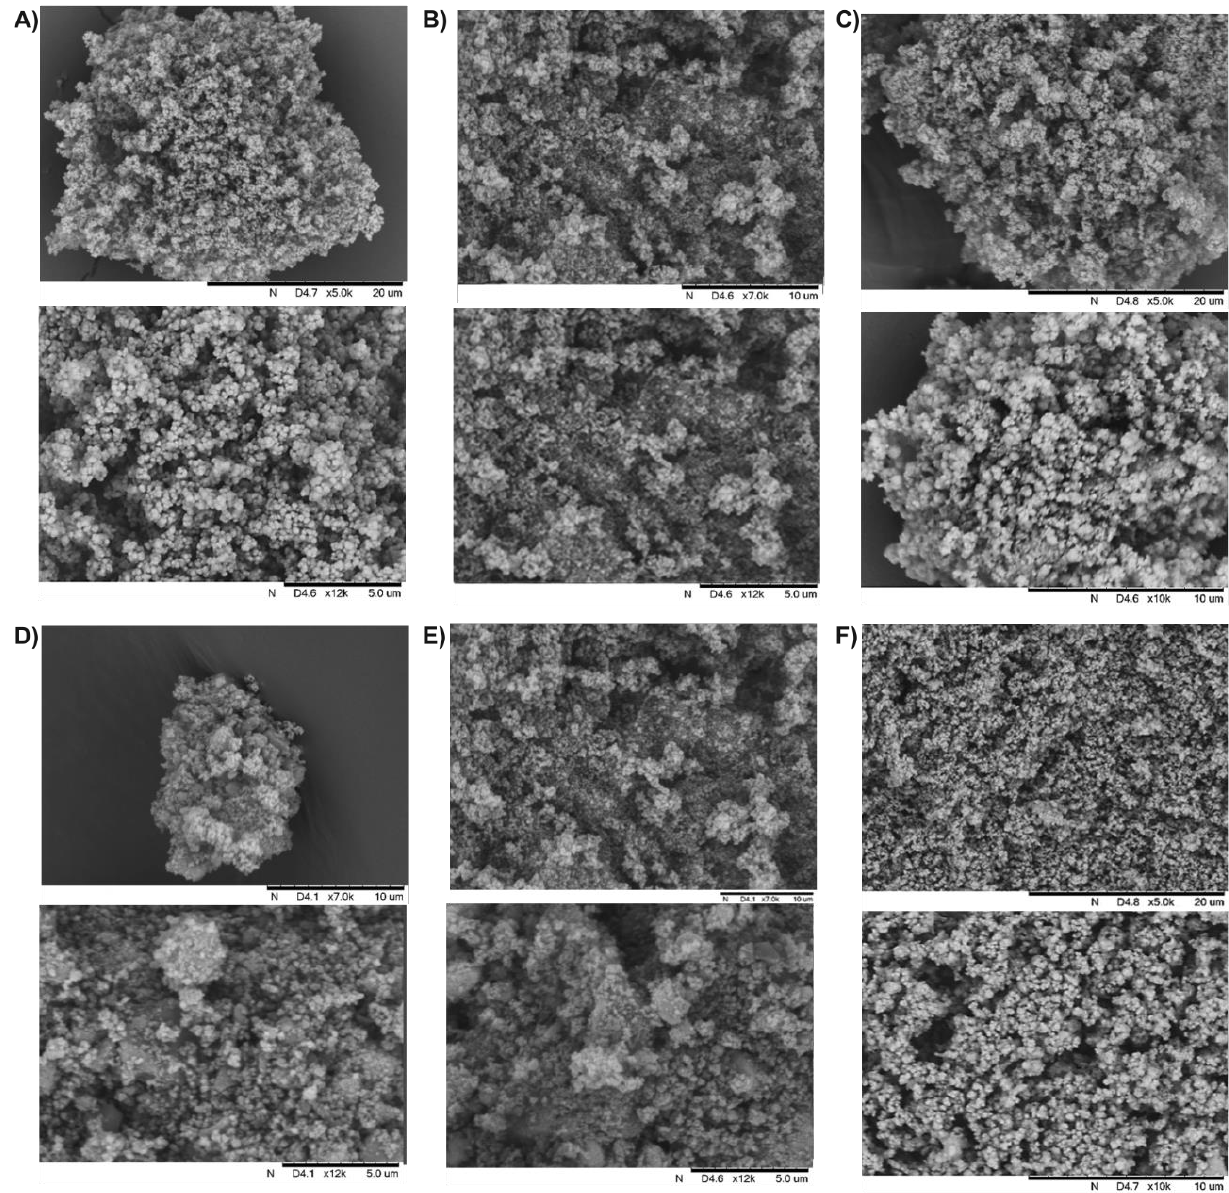
Figure 3. SEM images of the studied silica materials ( A – F ).